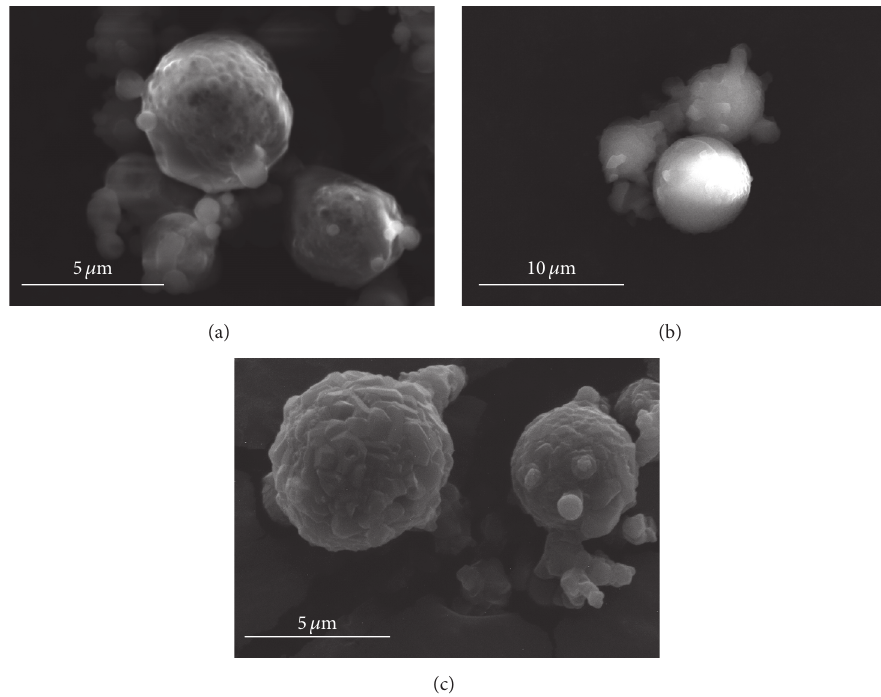
Figure 4: SEM images of alginate microspheres obtained by the spray drying method with metronidazole under magnification × 20 000 (a), ranitidine hydrochloride under magnification × 10000 (b), and metformin hydrochloride under magnification × 20 000 (c) (author’s unpublished